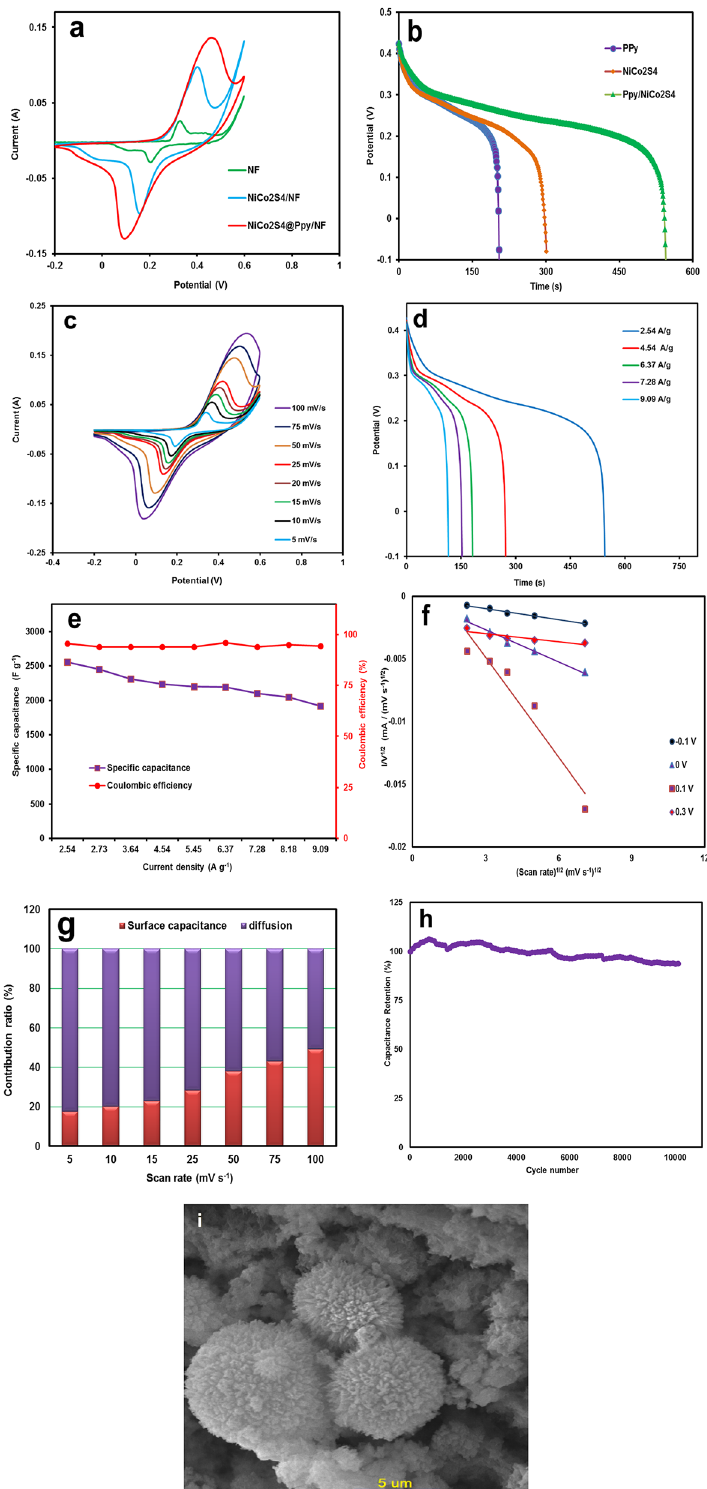
Figure 6. ( a ) Voltammograms recorded for the Ni-foam, NiCo 2 S 4 , and NiCo 2 S 4 @PPy nanomaterials at a scan rate of 50 mV s −1 , ( b ) comparison of the GCD curves of NiCo 2 S 4 @PPy, NiCo 2 S 4 , and Ni foam at a current density of 2.54 A g −1 , ( c ) CV curves of NiCo 2 S 4 @PPy electrode at different scan rates, ( d ) GCD curves of the NiCo 2 S 4 @PPy electrode at different current densities, ( e ) plots of specific capacitance and Coulombic efficiency against current density, ( f ) The plots of i(v)/ v 1/2 versus v 1/2 at various potentials, ( g ) Surface capacitive and diffusion-controlled contribution to the capacitance at various scan rates, ( h ) cycling life test of the NiCo 2 S 4 @ PPy electrode at a scan rate of 100 mV s −1 , and ( i ) the SEM image of NiCo 2 S 4 @PPy electrode at a scan rate of 100 mV s −1 after 2100